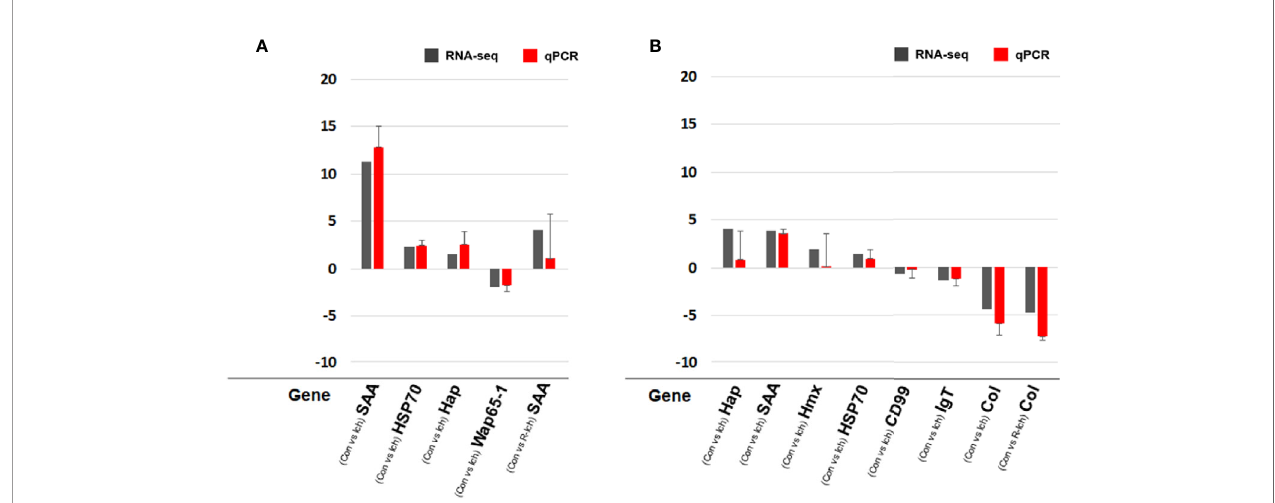
FIGURE 7 | Comparison of gene expression between the RNA-seq and qPCR results in the liver (A) and head kidney (B) targeting SAA, Hap, HSP70, Hmx, CD99, IgT, Wap65-1, and Col. The qPCR results in the bar graph are shown as mean ± standard